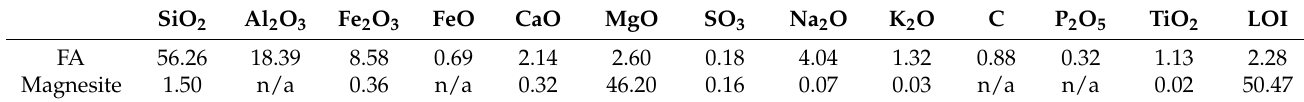
Figure 1. The XRD patterns of the FA and natural magnesite. Phases marked are: Q—quartz SiO 2 (ICDD 00-046-1045), M—mullite 3Al 2 O 3 ·2SiO 2 (ICDD 00-015-0776), G—magnesite MgCO 3 (ICDD 01- Table 1. Chemical composition of the FA and magnesite, wt.%. (n/a—not analyzed).